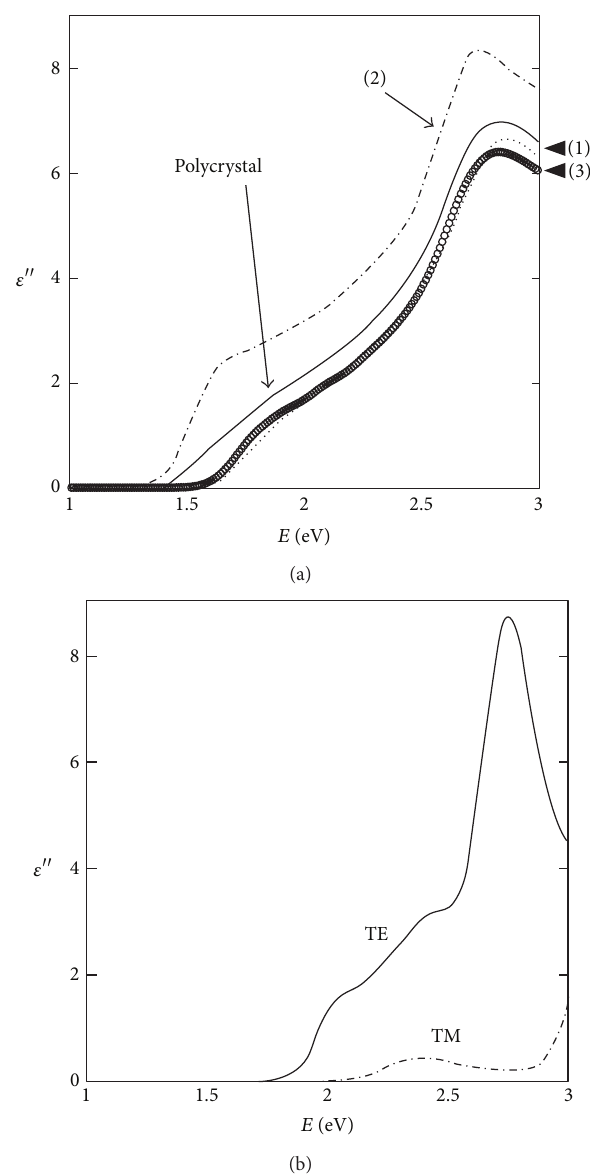
Figure 5: Imaginary parts of the dielectric functions com- puted without SOC at the GGA-level for CH 3 NH 3 PbI 3 (a) and (C 5 H 11 NH 3 ) 2 PbI 4 (b). The results are given for light polarizations along the three crystallographic axes (1–3) or for a polycrystalline sample in the case of CH 3 NH 3 PbI 3 (a) and for TE or TM (perpen- dicular to the stacking axis) polarizations for (C 5 H 11 NH 3 ) 2 PbI 4